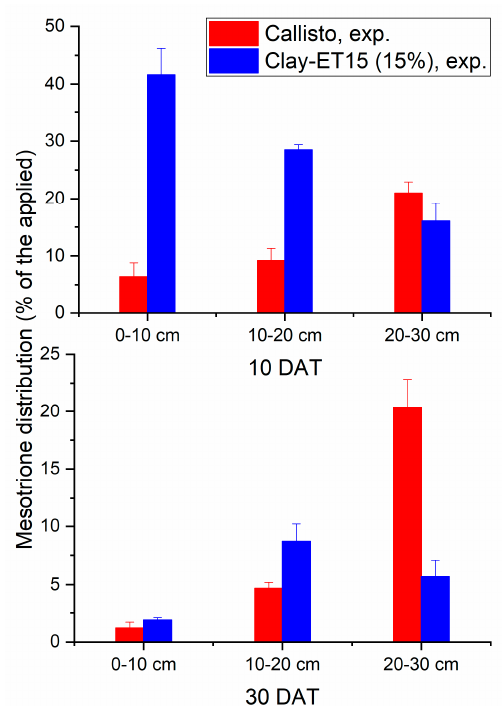
Figure 5. Mesotrione distribution applied post-emergence as a commercial formulation (Callisto, 10% ai w:v ) and a micelle-clay-ET15 (15% ai w:w ) in soil depth 10 and 30 DAT. Adapted from [54]. Table 4. Slow release formulations (SRFs) of several representative herbicides, based on quaternary ammonium cations (QACs)-clay composites; Montmorillonite (MMT). Surfactant Modifier Herbicide Clay/Mineral Clay Reference; [Remarks]